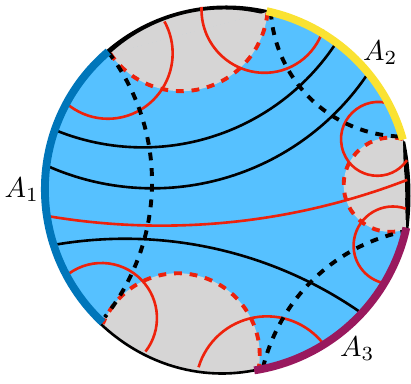
Figure 22 . Minimal surfaces are shown as dashed lines and (cid:13)ows as solid lines. The maximum multi(cid:13)ow the manifold can support is represented here, but not all (cid:13)ow lines are shown as each dashed line is saturated. To create a valid (cid:13)ow con(cid:12)guration in the feasible set of (3.11) we delete each thread shown in